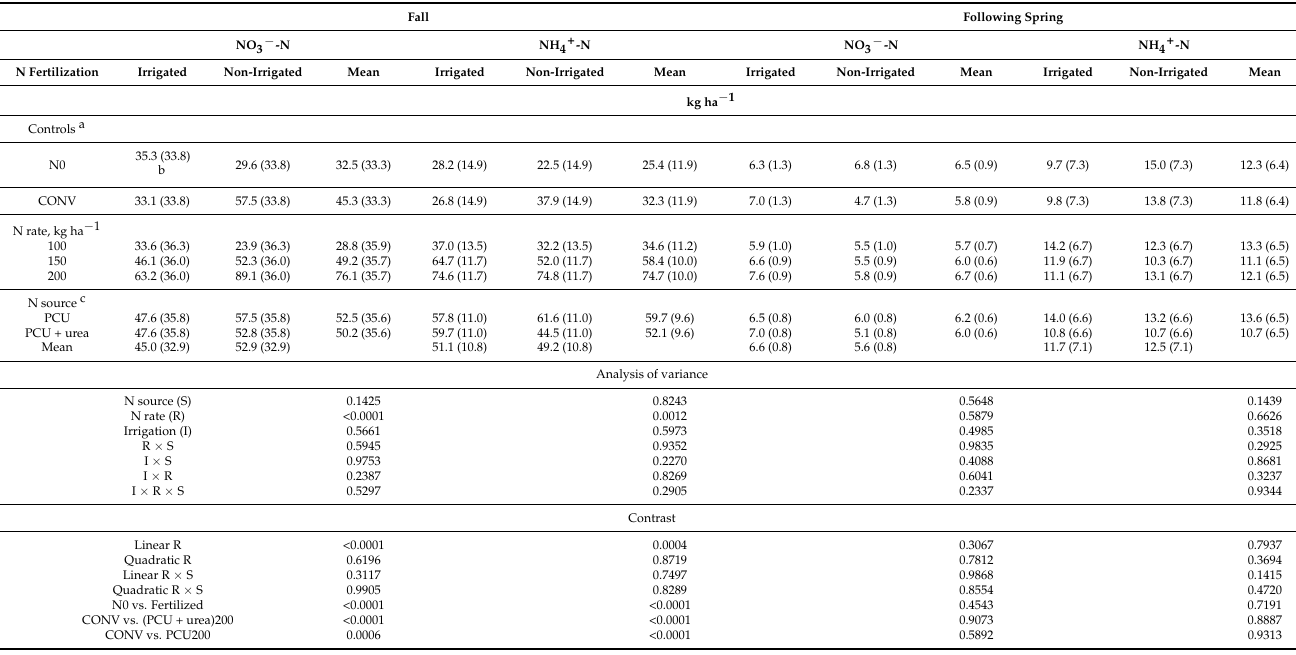
Table 7. Effect of N fertilization (rate and source) on residual soil NO 3 − -N and NH 4+ -N content (0–90 cm) in fall and in the following spring.